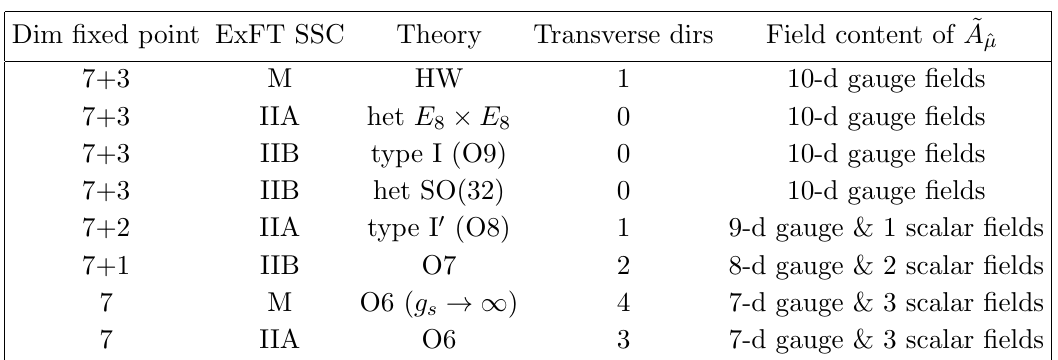
Table 6 . Different theories captured by the Z 2 orbifold of the SL(5) ExFT. Depending on the number of the transverse directions (which are always reflected), only a subset of the ∂ k section condition. The corresponding ˜ A k are either components of gauge fields or adjoint scalars.